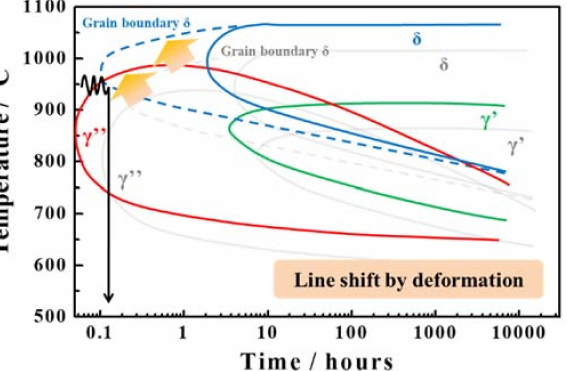
Figure 13. Schematic illustration of shift of PTT diagram during hot working at deformation temper- ature of 950 ◦ C and high strain